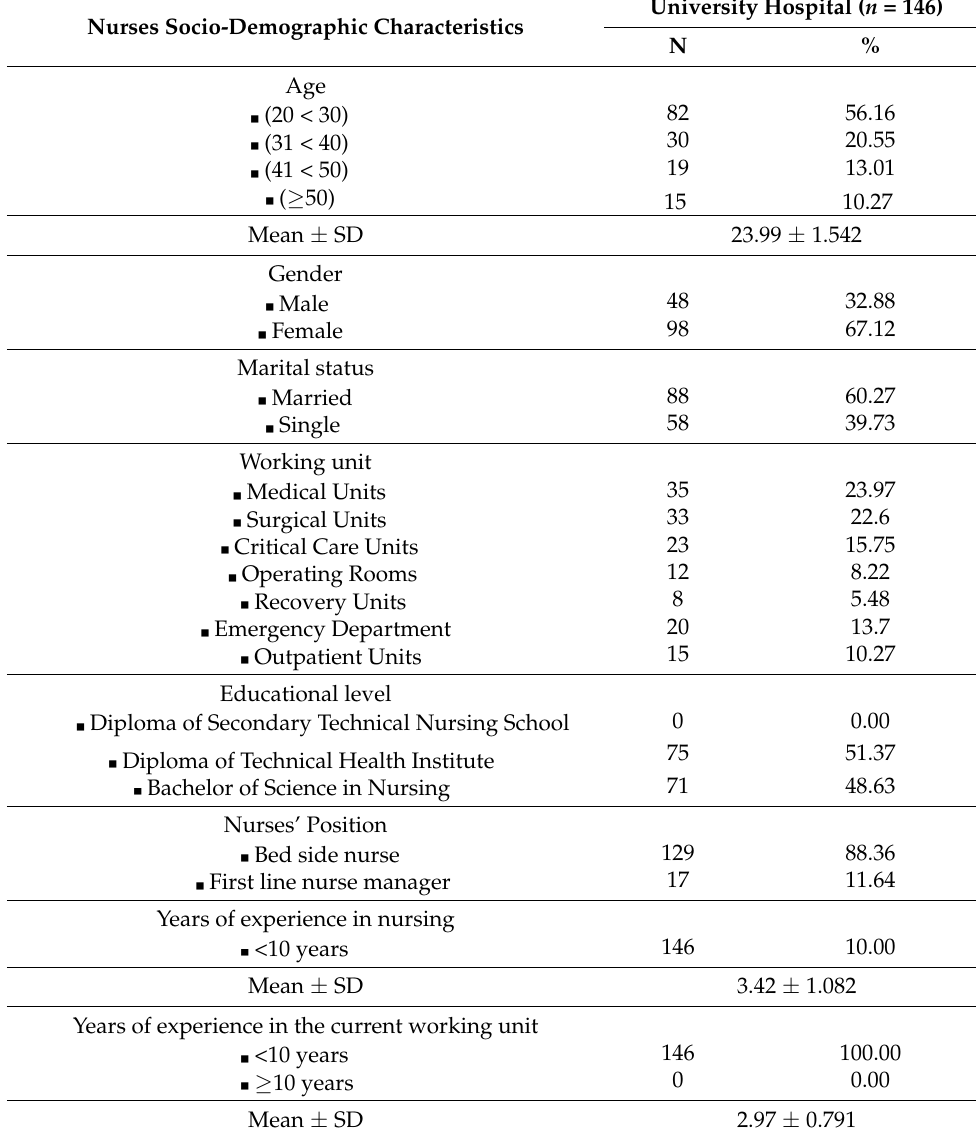
Table 1. Socio-Demographic and Work-Related Characteristics of the Study Subjects. Nurses Socio-Demographic Characteristics